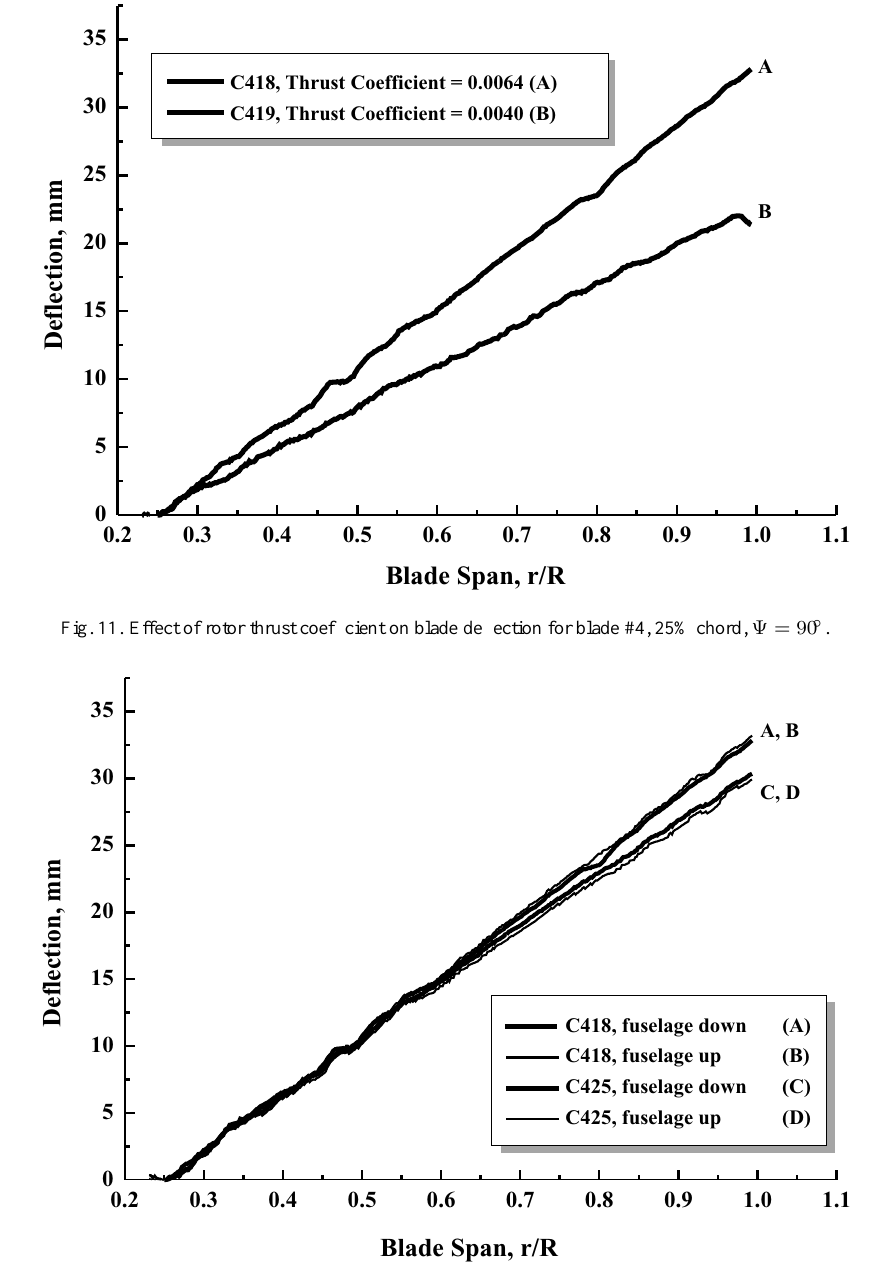
Fig. 12. Fuselage effects on mean blade deflection for blade #4, 25% chord, Ψ = 90 ◦